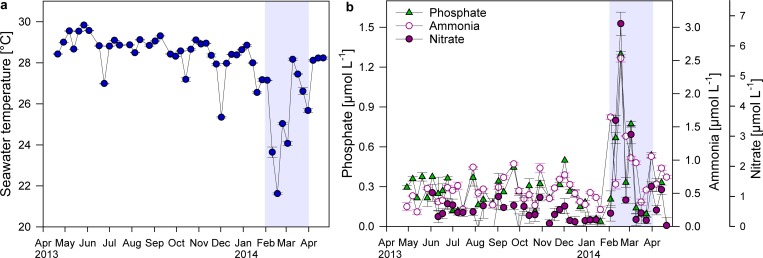
Changes in temperature and nutrient concentrations.Displayed are mean ± SE values for (A) water temperature (measured over 1–6 h in 4 min intervals) and (B) nutrient concentrations (n = 3) directly above the reef substrate from April 2013 to April 2014 in a weekly resolution. Shading indicates period of strongest upwelling in February and March.